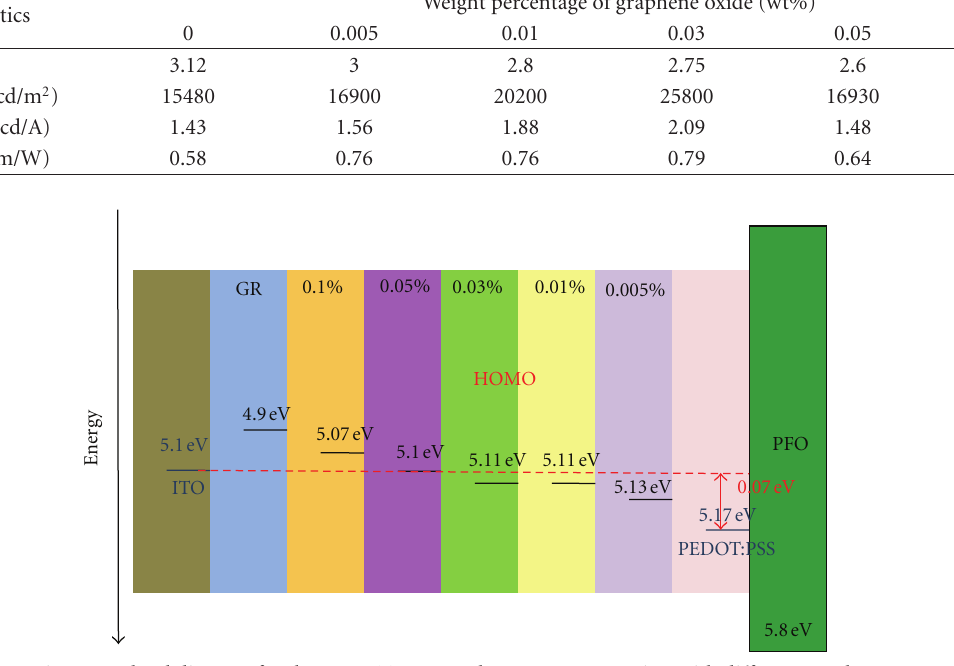
current) and luminous power e ffi ciency (lm/W,